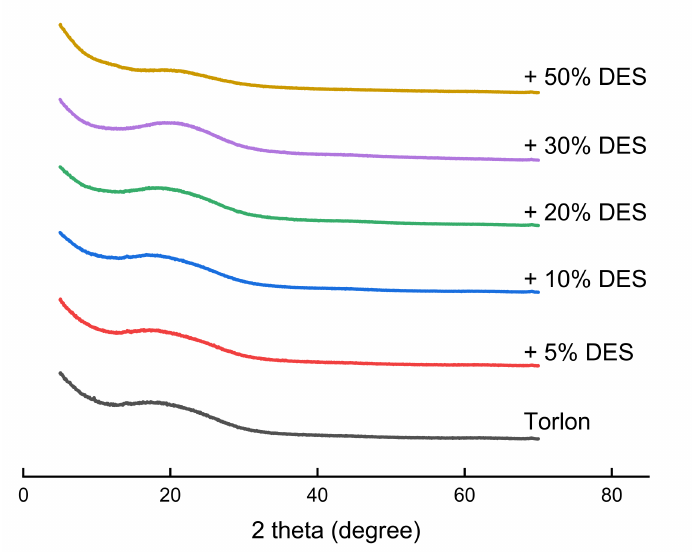
Figure 3. XRD patterns of pure Torlon and Torlon/DES (5–50%) composites.